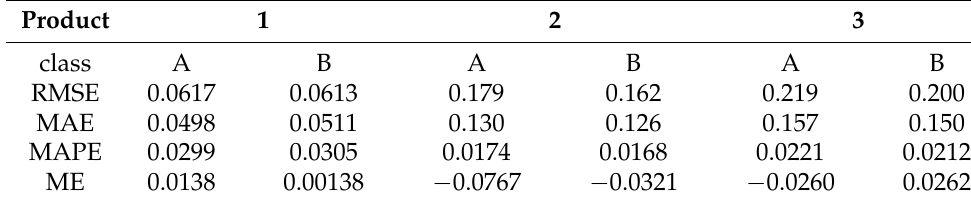
Table 9. Performance of the fine-tuned deep learning models on the test